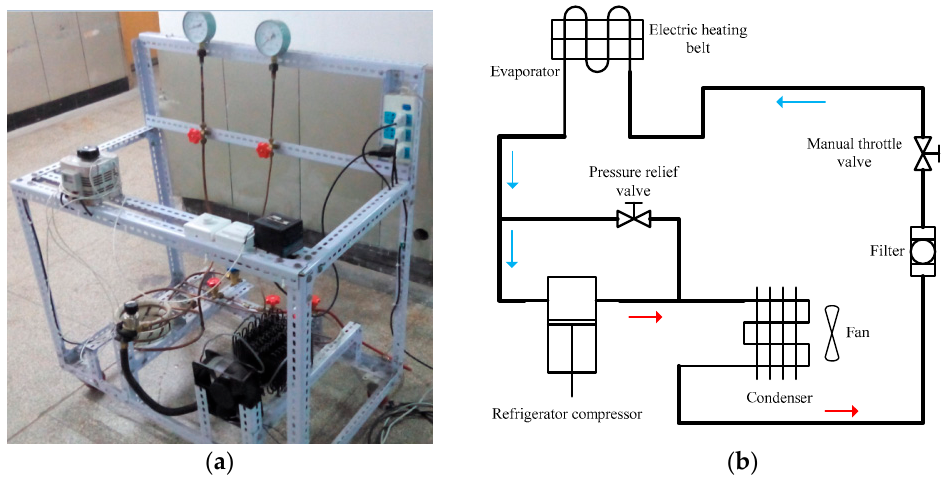
Figure 10. Test facility for refrigeration system: ( a ) Refrigeration system; ( b ) An evaporator and other additional components.